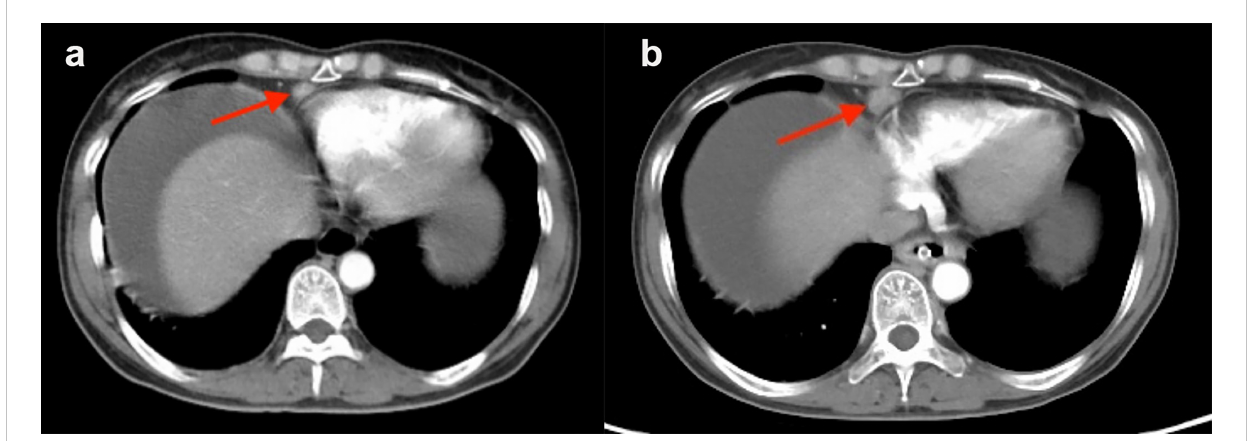
FIGURE 7 Staging CT image of a patient with FIGO stage IIIC ovarian cancer who presented with an enlarged cardiophrenic lymph node (CPLN) of 6.4 mm in the short axis (A) . The CPLN had grown to 11.3 mm 5 months later, but the patient had no recurrence in the abdomen (B) .